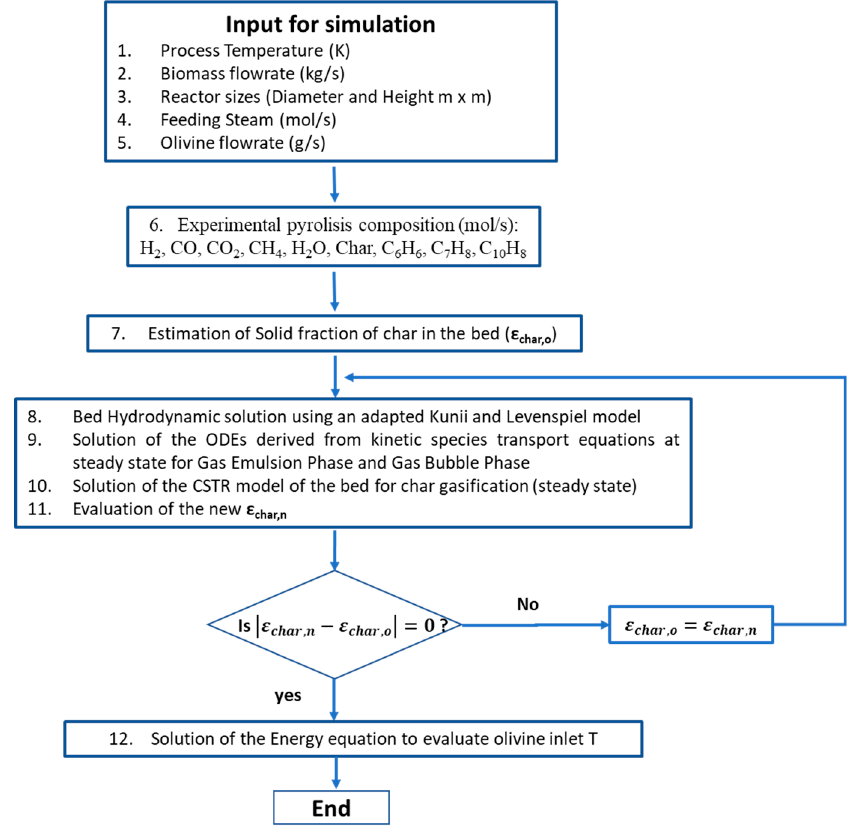
Figure 2. MATLAB model algorithm flow chart.